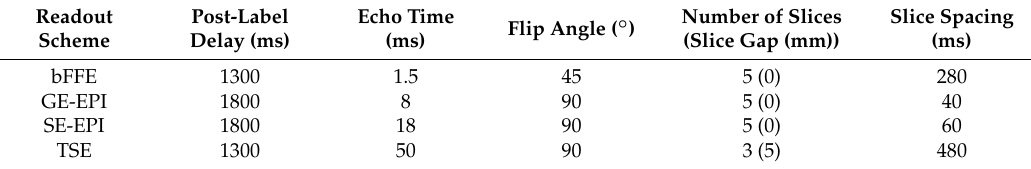
Table 1. Imaging parameters for the balanced fast field echo (bFFE), gradient-echo echo-planar